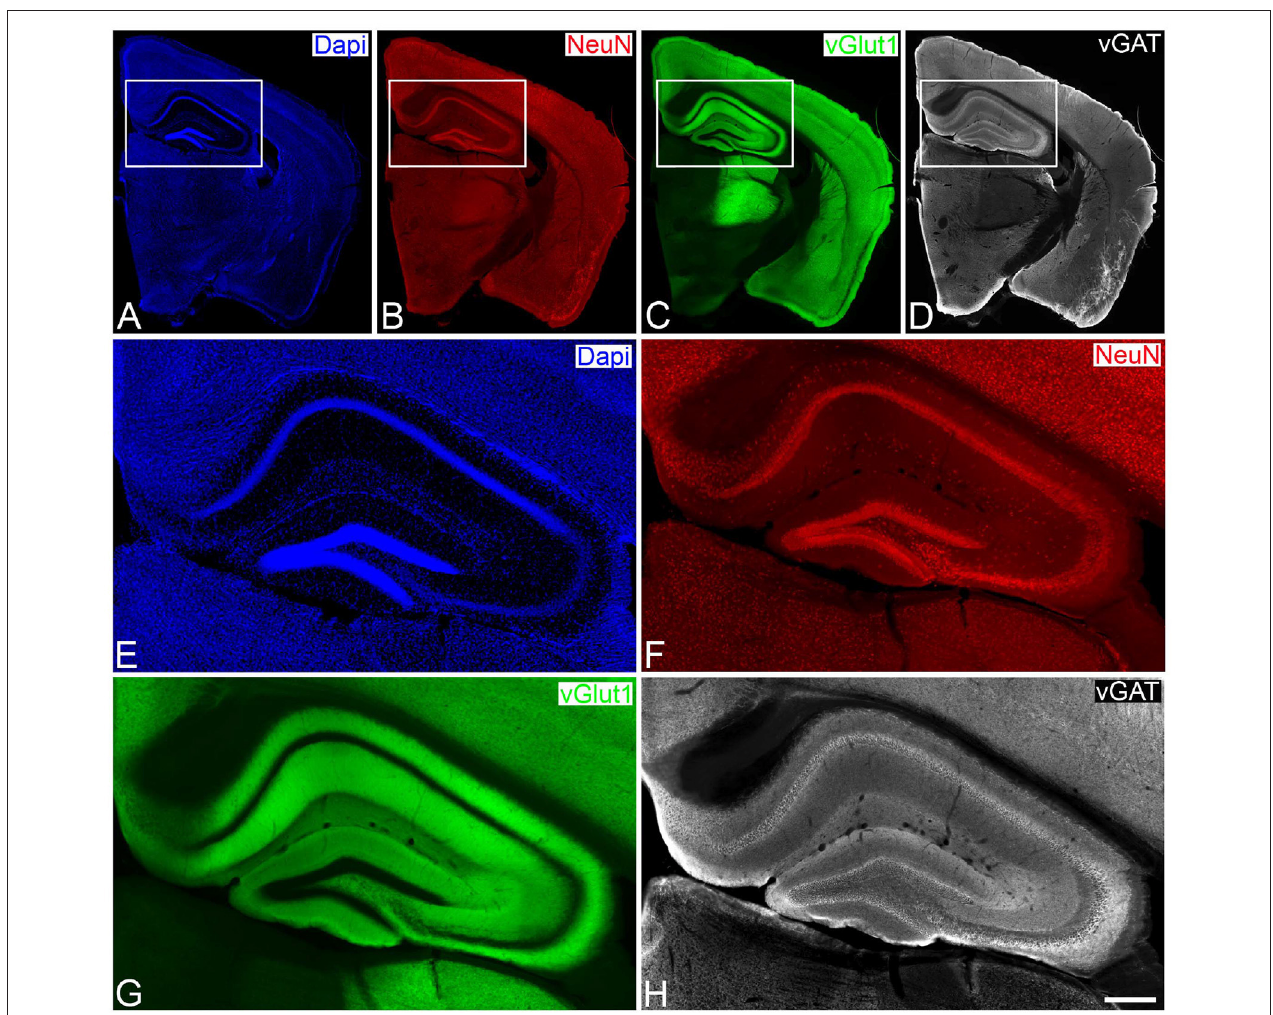
FIGURE 1 | Low- (A–D) and higher- (E–H) power photomicrographs obtained with a conventional fluorescence microscope (tile scan; 10x objective), showing patterns of Dapi staining, and NeuN and vGat immunostaining of a brain section from a vGlut-1-transgenic mouse. The hippocampal region, squared zones in A–D , is shown at higher magnification in E–H , respectively. Scale bar (in H ): 1,200 µ m in A,B ; 275 µ m in E–H